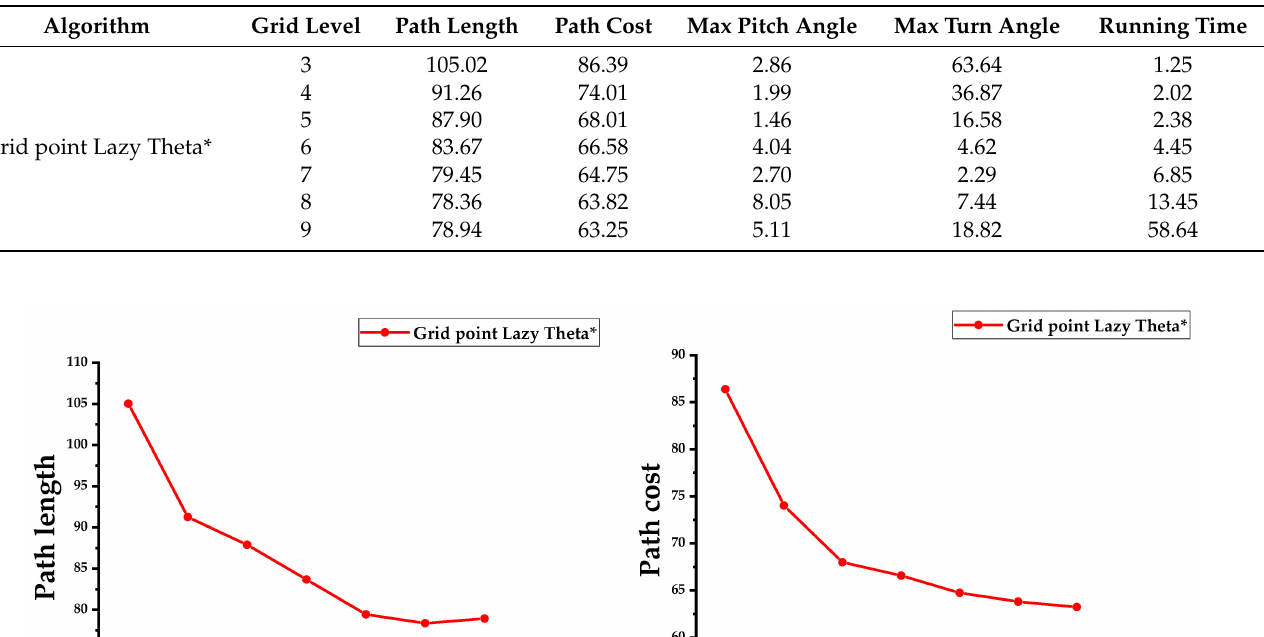
Table 3. Lazy Theta* route planning data of different grid levels.